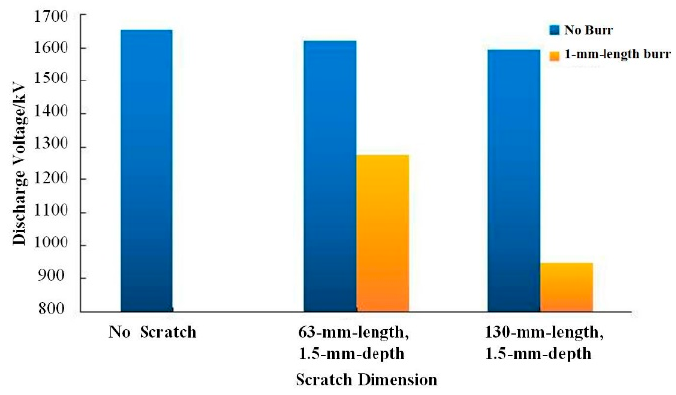
Figure 4. Switching impulse voltage comparison before and after scratch.